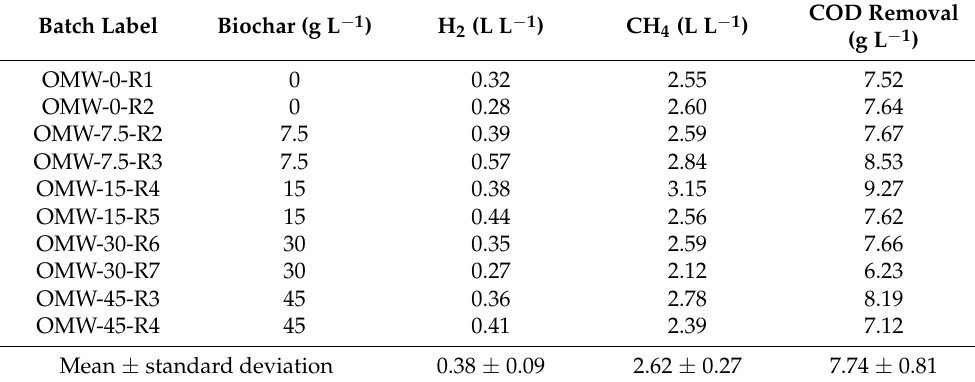
Table 2. Cumulative volumes of hydrogen and methane collected during each digestion test and estimated COD removal for biogas production. Cumulative volumes are reported as liters of gas at 0 ◦ C and 1 atm per liter of digestate. H 2 was collected only during the first phase, and CH 4 was collected during both phases of biogas production. COD removal was calculated from Equation